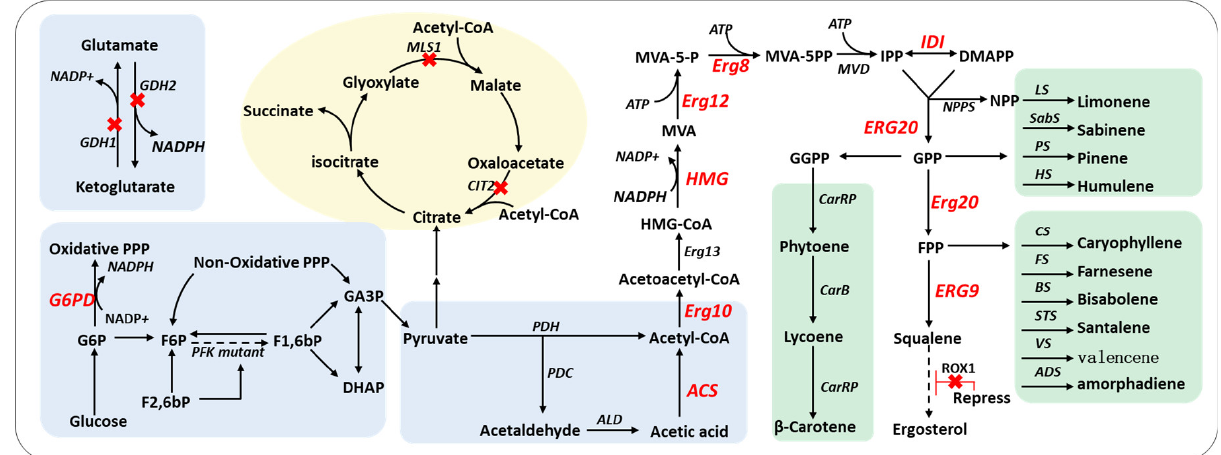
Figure 1. The biosynthesis and regulation pathways of terpenes. LS, limonene synthase; SabS,